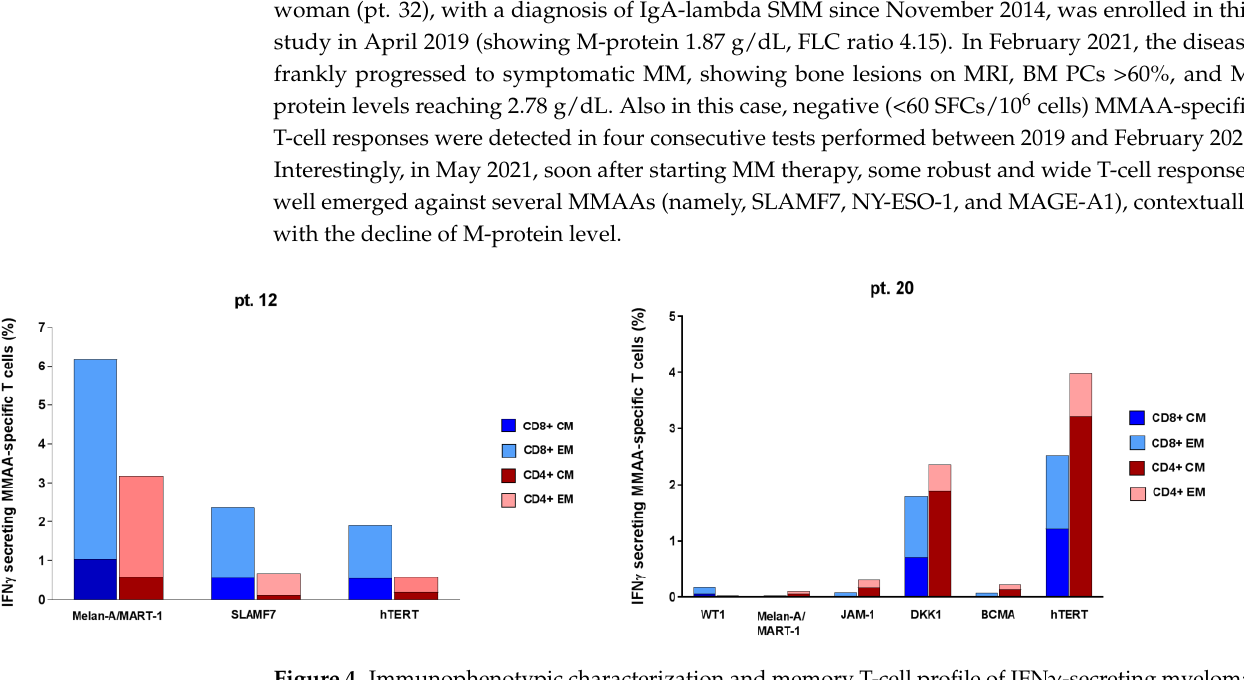
Figure 4. Immunophenotypic characterization and memory T-cell profile of IFN γ -secreting myeloma-specific T cells. EM = Effector Memory; CM = Central memory; MMAAs = Multiple Myeloma Associated Antigens.